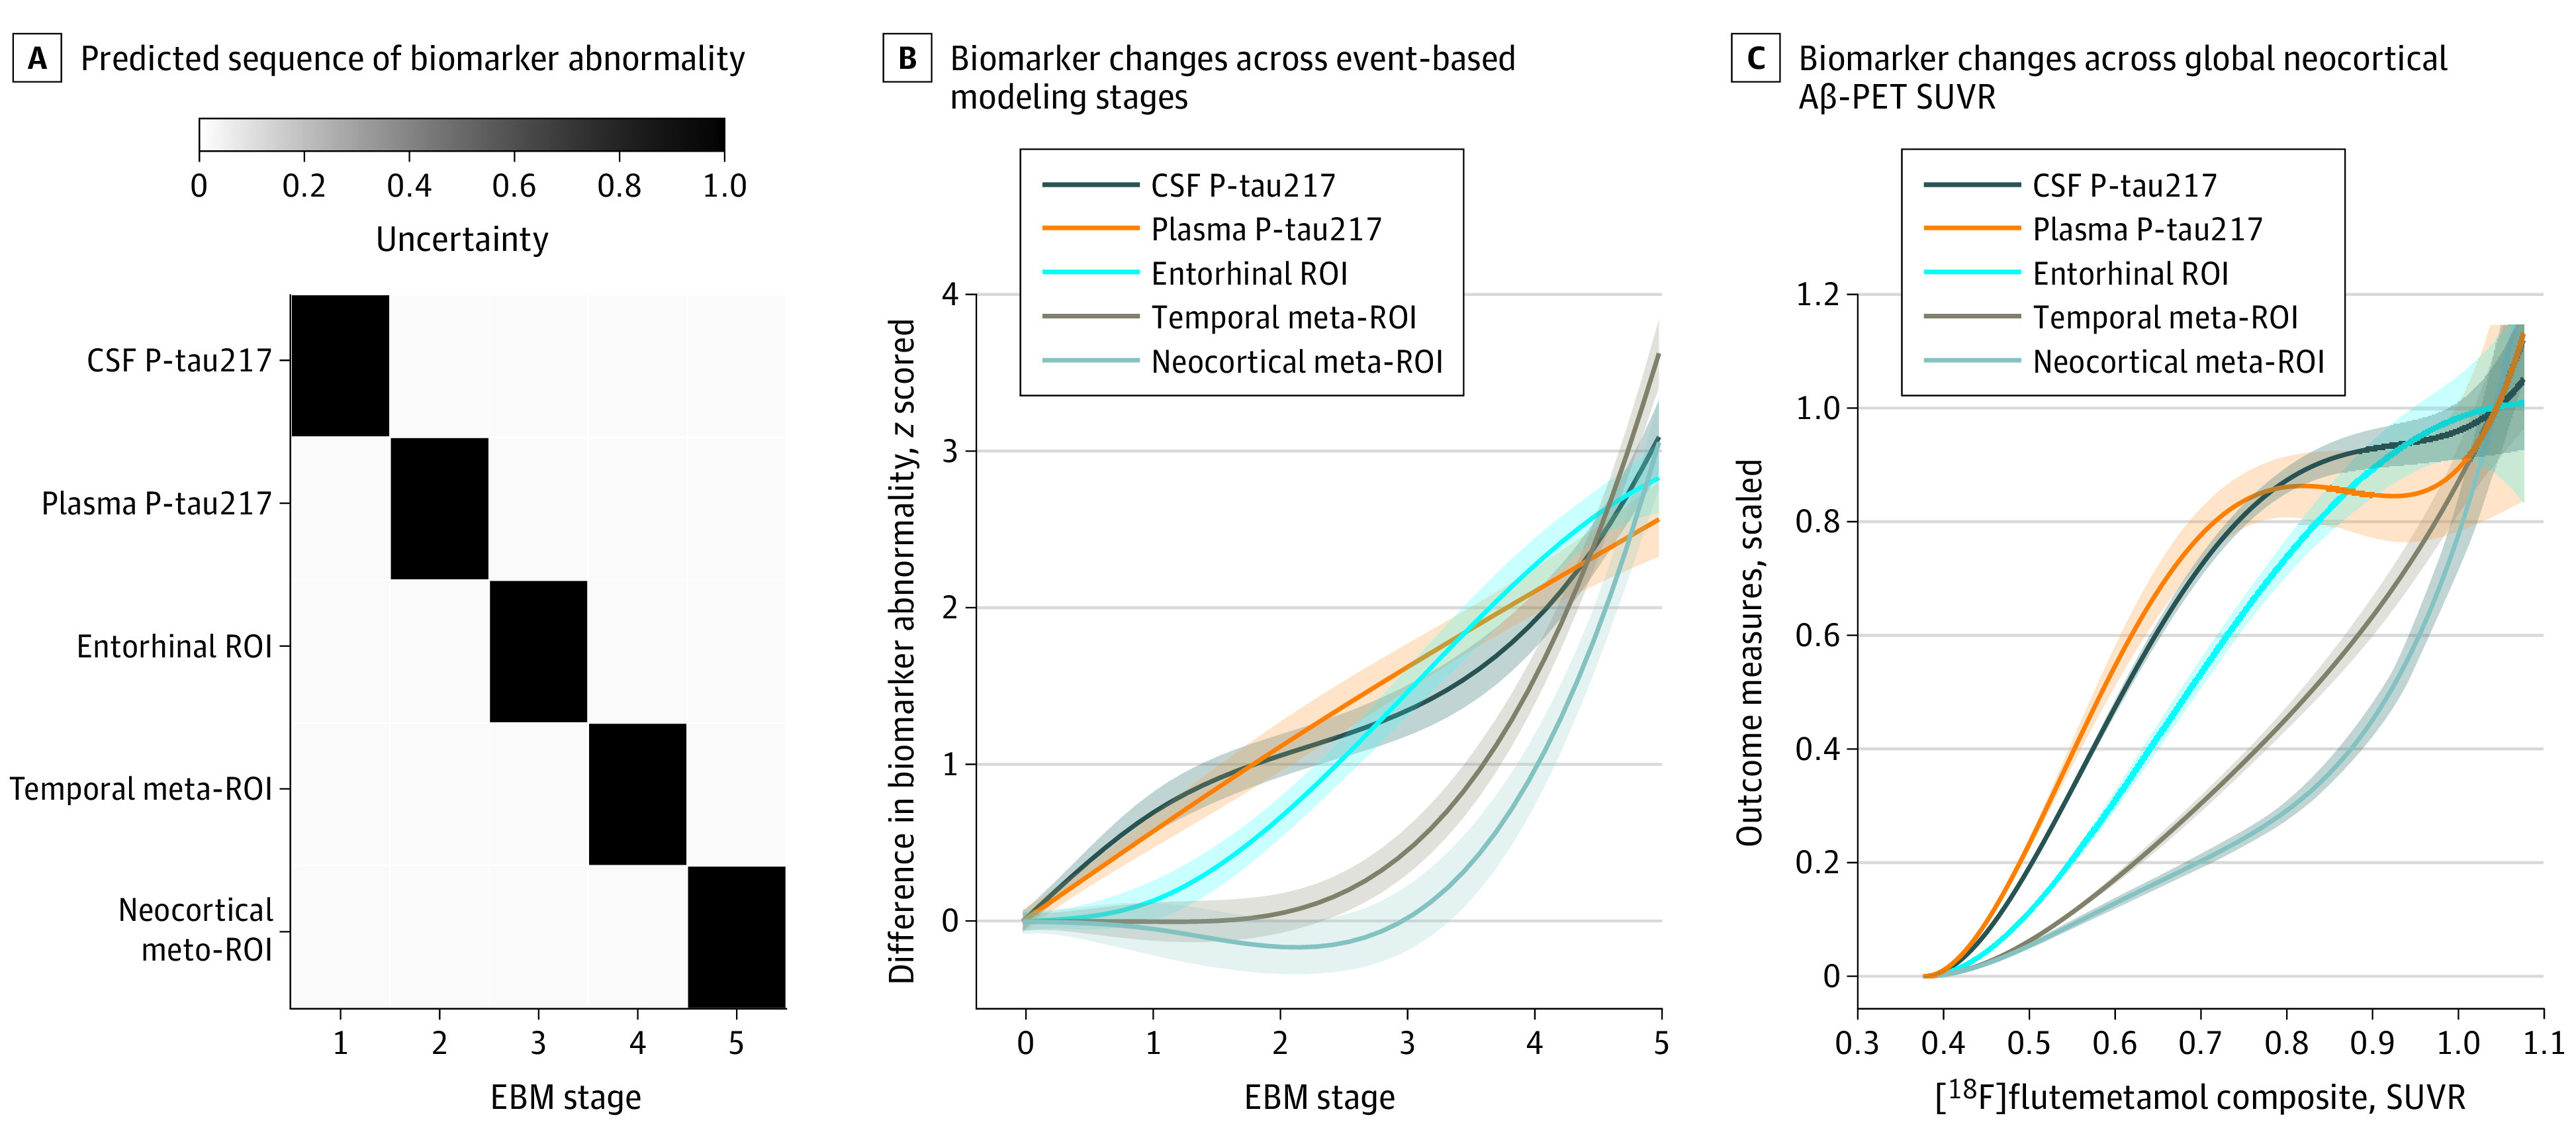
Order of Change in Plasma Tau Phosphorylated at Threonine 217 (P-tau217), Cerebrospinal Fluid (CSF) P-tau217, and Tau–Positron Emission Tomography (PET) AbnormalityOrder of change in plasma P-tau217, CSF P-tau217, and tau-PET abnormality in cognitively unimpaired participants and those with mild cognitive impairment (n = 484). A, Predicted sequence of biomarker abnormality from event-based modeling (EBM). Gray scale coding indicates uncertainty. B, Visualization of biomarker changes across EBM stages using nonlinear spline models. Uncertainties represent 95% CIs from the model-estimated variance-covariance matrix. C, Summary of biomarker changes in relation to global neocortical amyloid β (Aβ)–PET. All biomarkers are on a common scale ranging from 0 (baseline levels) to 1 (the mean levels in the top 10 percentiles). ROI, region of interest; and SUVR, standardized uptake value ratio.